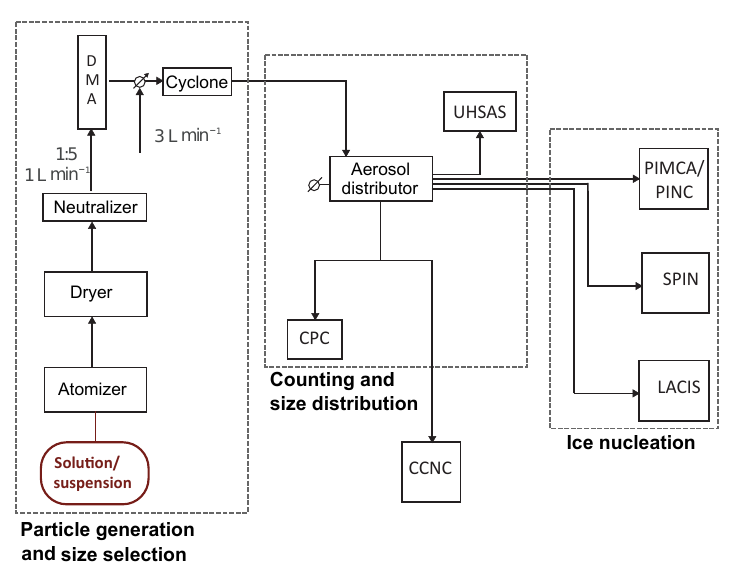
Figure 1. Schematic of the intercomparison setup during LINC. Components include a differential mobility analyzer (DMA), condensa- tion particle counter (CPC), cloud condensation nuclei counter (CCNC), ultra-high-sensitivity aerosol spectrometer (UHSAS), the Leipzig Aerosol Cloud Interaction Simulator (LACIS), the Portable Immersion Mode Cooling chAmber (PIMCA), the Portable Ice Nucleation Chamber (PINC), and the Spectrometer for Ice Nuclei